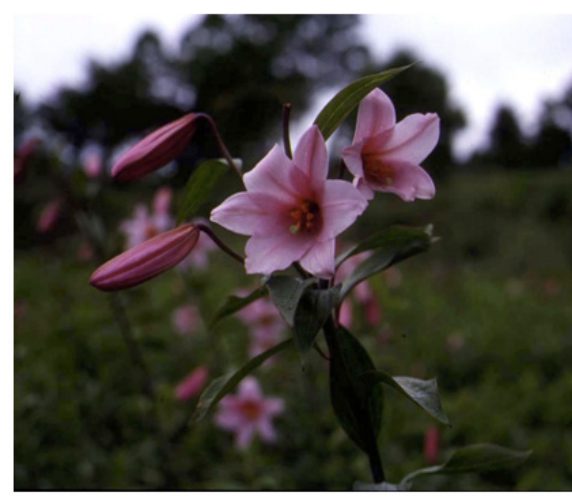
Figure 2. Rose Lily in Mt. Azuma